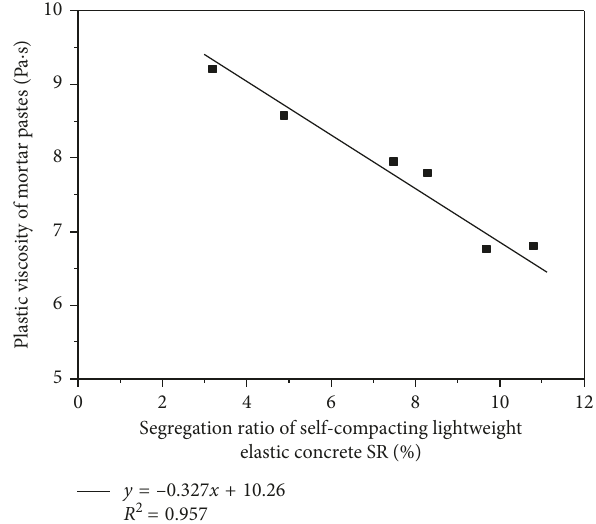
Figure 20: Relationship between segregation ratio of SCRLC and plastic viscosity of corresponding mortar pastes.